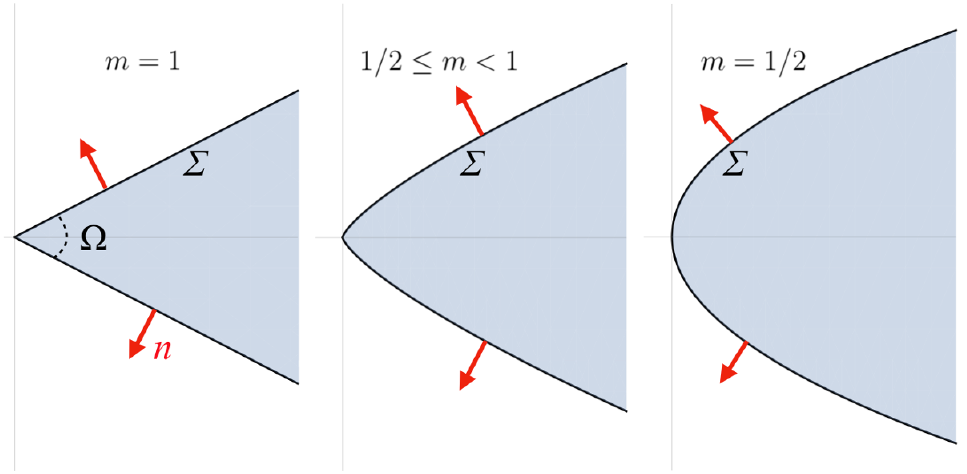
Figure 6 . We plot entangling regions on a time slice of a three-dimensional CFT bounded by the curves y ( x ) = (cid:6) (cid:21)x m ( x (cid:21) 0) with m = 1 (left), 1 = 2 (cid:20) m < 1 (middle) and m = 1 = 2. The usual logarithmic universal term in the entanglement entropy (cid:24) a ((cid:10)) log( H=(cid:14) ) characteristic of the straight corner ( m = 1) is no longer present for m < 1, even though the entangling surface is still singular at the tip for 1 = 2 (cid:20) m <